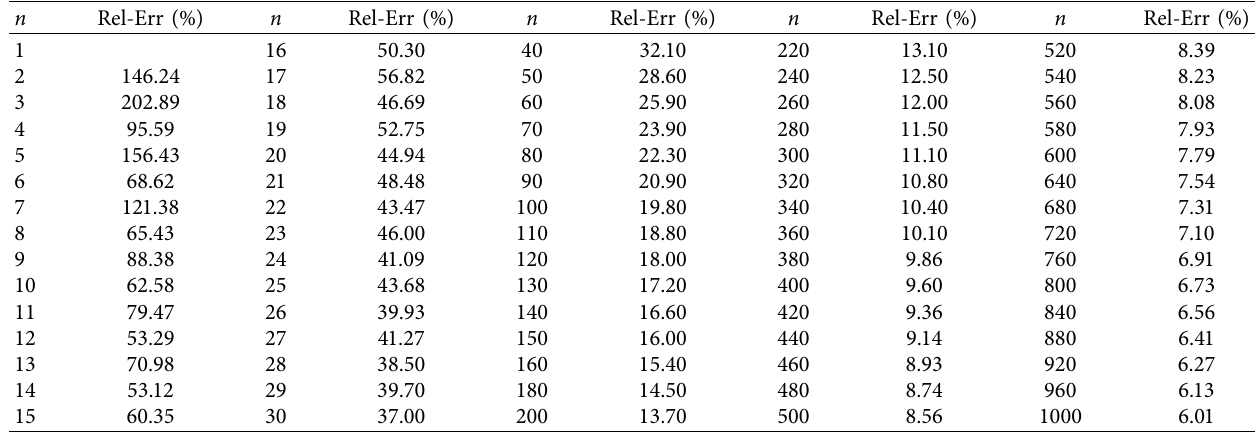
( n ) + 1/2 􏽪 􏽫 to h ( n ) when n ≤ 30. g 2